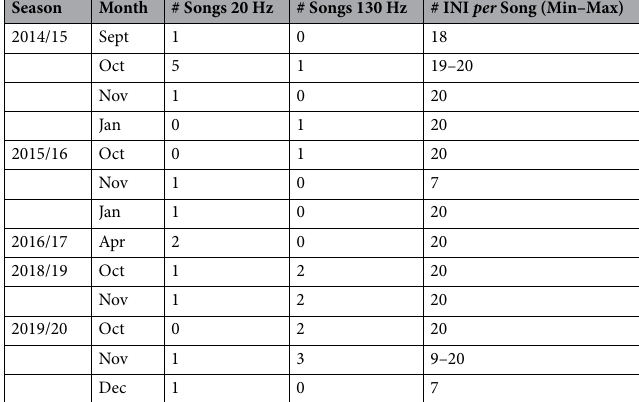
Table 1. Number of songs and INIs analysed per month and singing season.